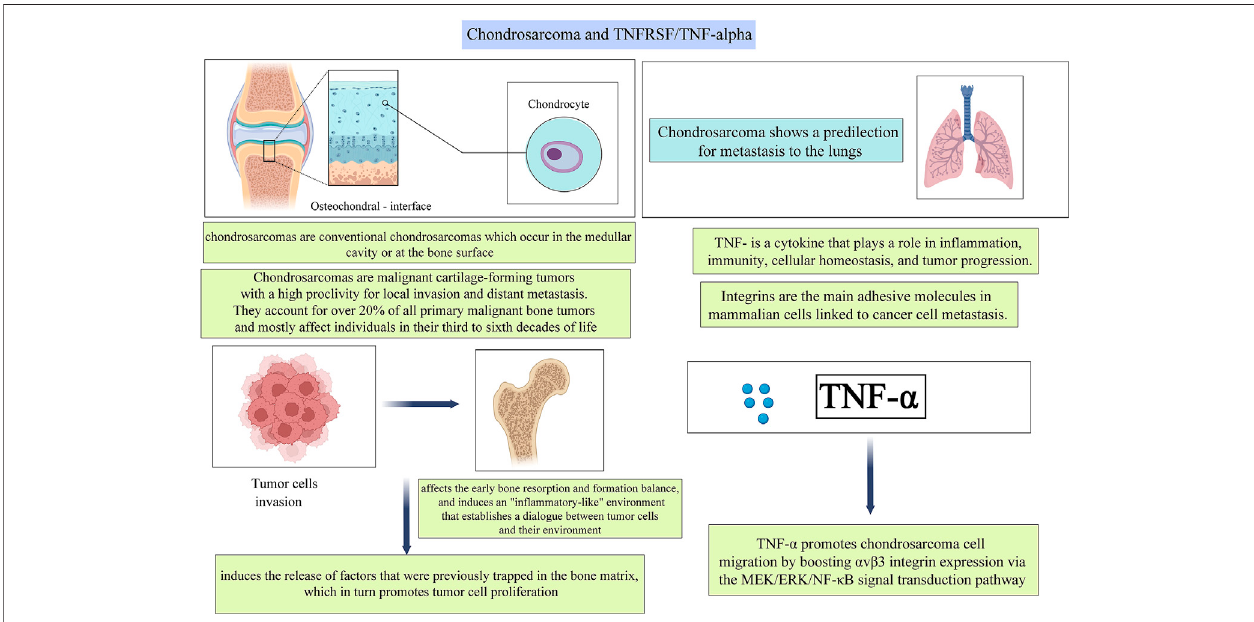
FIGURE 4 | A pictorial description of the relationship between TNFs and TNFRs and their roles in Chondrosarcoma.